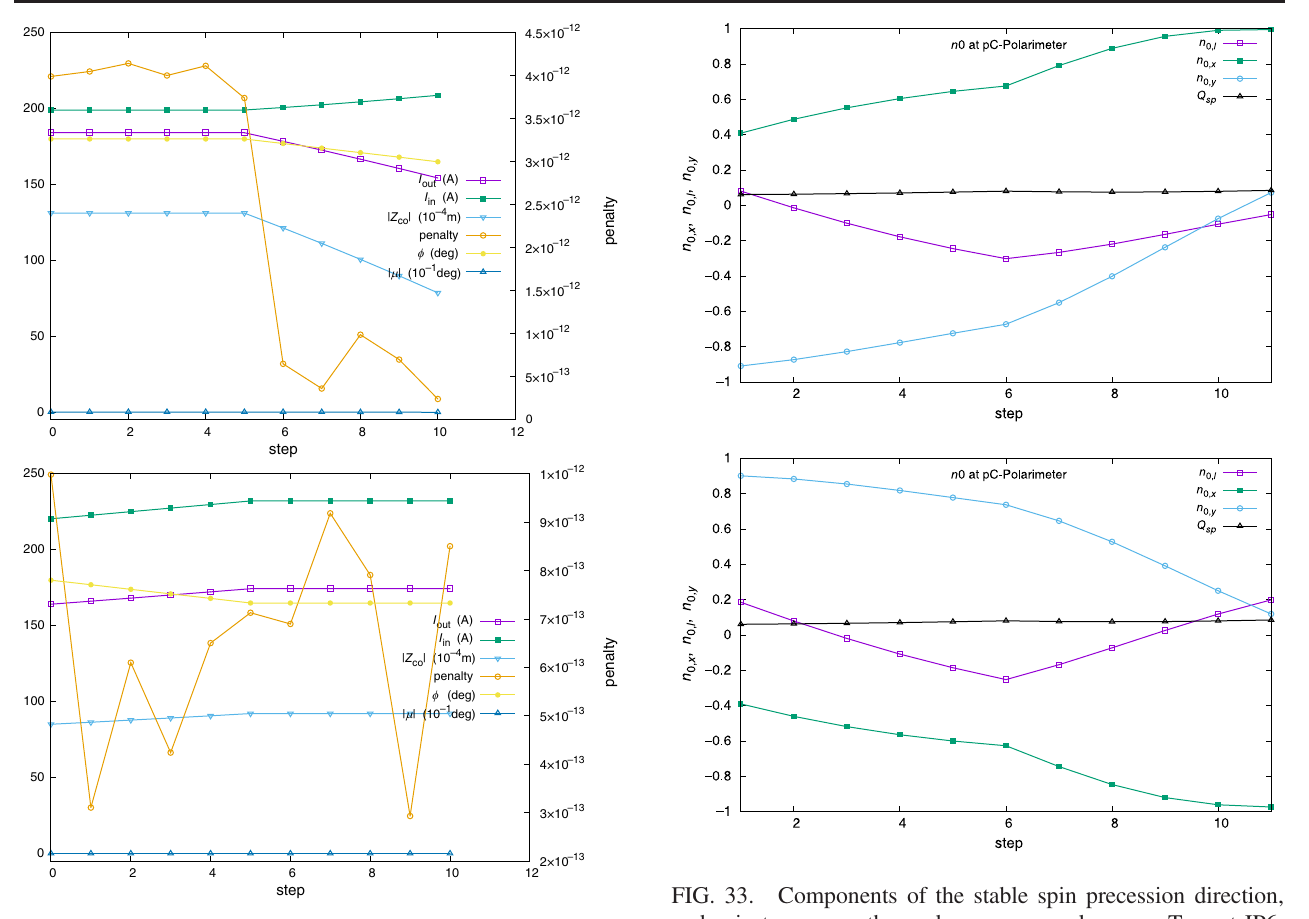
FIG. 32. Required ramp of snake angles μ and ϕ , for rotation of RHIC Yellow ring polarization from vertical to radial; OPERA currents necessary for that, obtained by constraining the snake spin matrix; resulting closed orbit coordinate at snake entrance; and monitoring the convergence of this fit: fit penalty (right vertical axis). Top: 9 o ’ clock snake; bottom: 3 o ’ clock snake. The right axis in these graphs gives the penalty function values, other quantities use the left